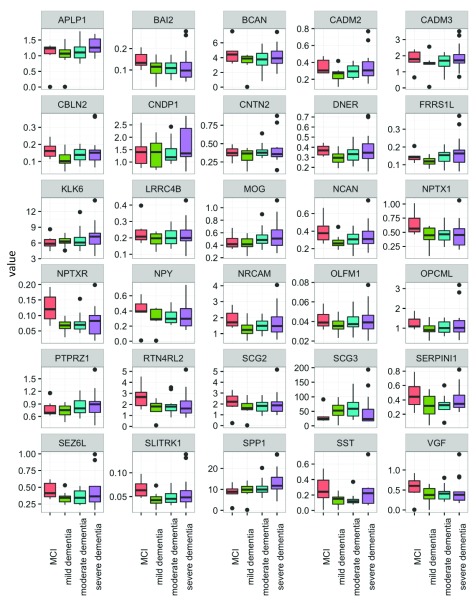
Distribution of candidate protein biomarkers in cerebrospinal fluid samples of set 2 (see text for definitions).Candidate proteins were measured with SRM assay and compared between mild cognitive impairment (MCI) (n=6), mild (n=8), moderate (n=16) and severe AD (n=13). Full gene names can be found in the website of the human gene nomenclature committee (
https://www.genenames.org/).